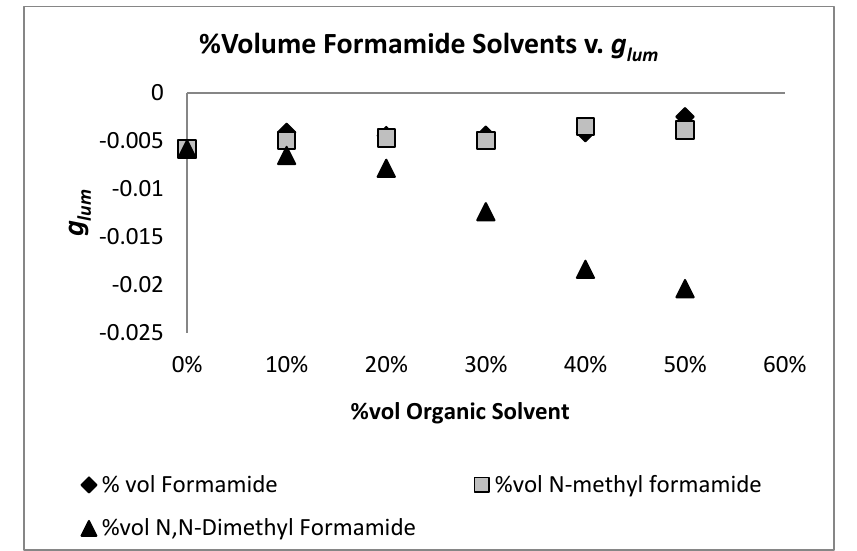
Figure 2. g lum [Tb(DPA) 3 ] 3− with formamide (circle), N -methyl formamide (square), and N,N -dimethyl formamide (triangle).